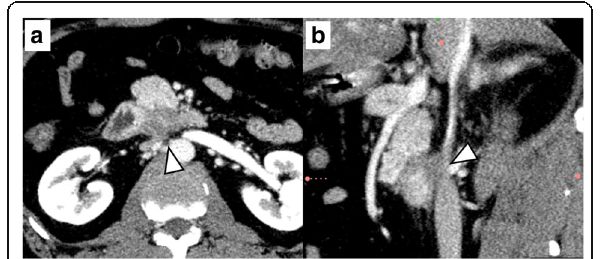
Fig. 1 Preoperative computed tomography image of case 1. a Dense soft tissue of the pancreatic tumor contacting the ventral surface of the inferior vena cava (IVC) ( arrowhead ). b Sagittal multi-planar reformation showed that the interface between the tumor and the IVC was not well defined